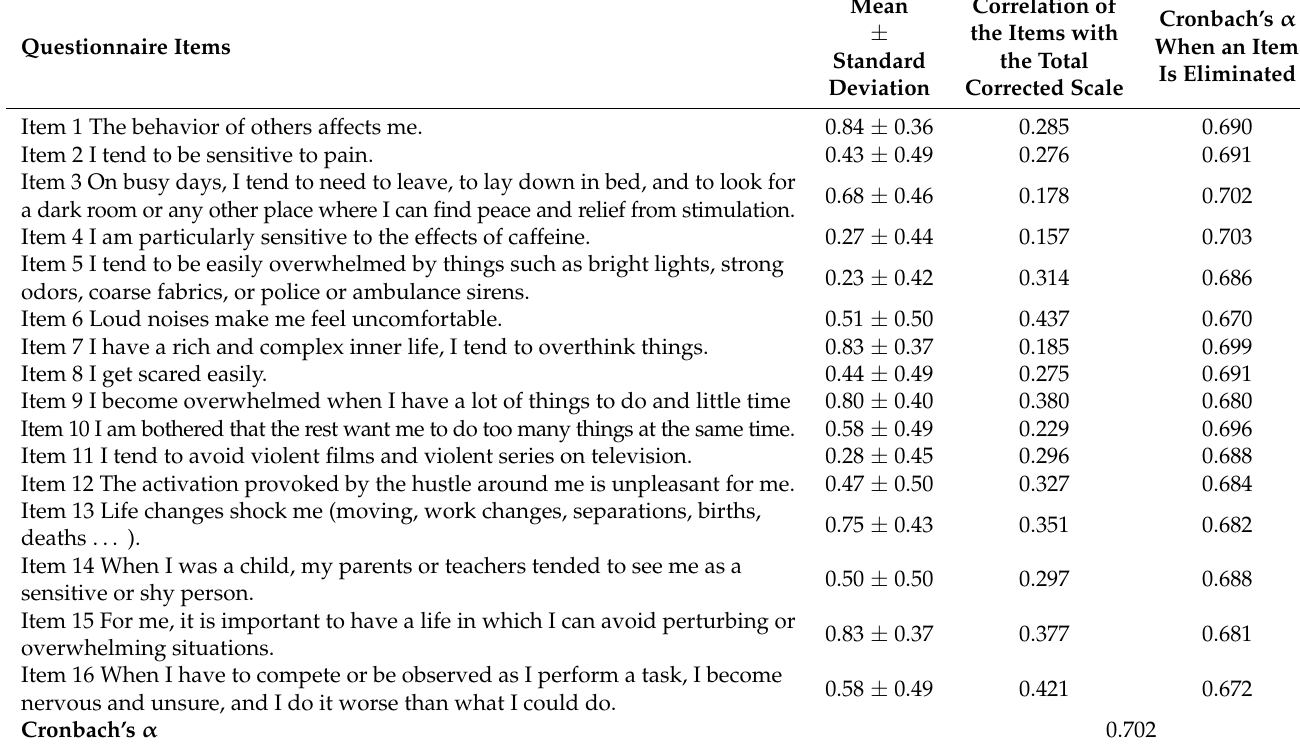
Table 3. Homogeneity analysis of the questionnaire.